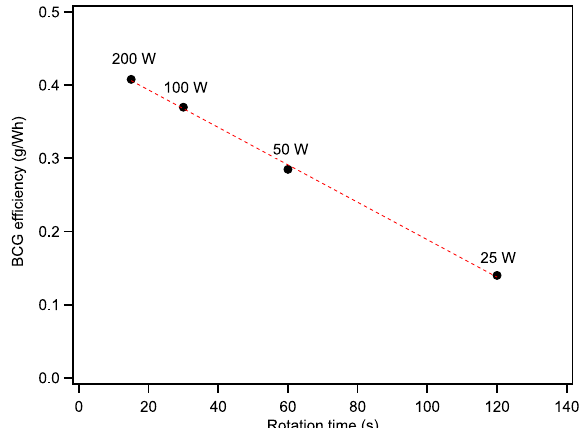
Figure 2. Graphite production irradiated energy efficiency plotted as a function of the duration of a full rotation of the pellet while irradiated at indicated laser output power scaled for a constant energy input of 0.83 Wh. Dashed line is a linear least squares fit of the